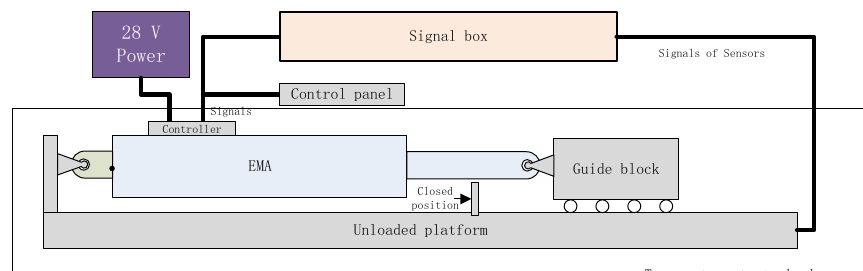
Figure 9. Block diagram of the loaded experiment.